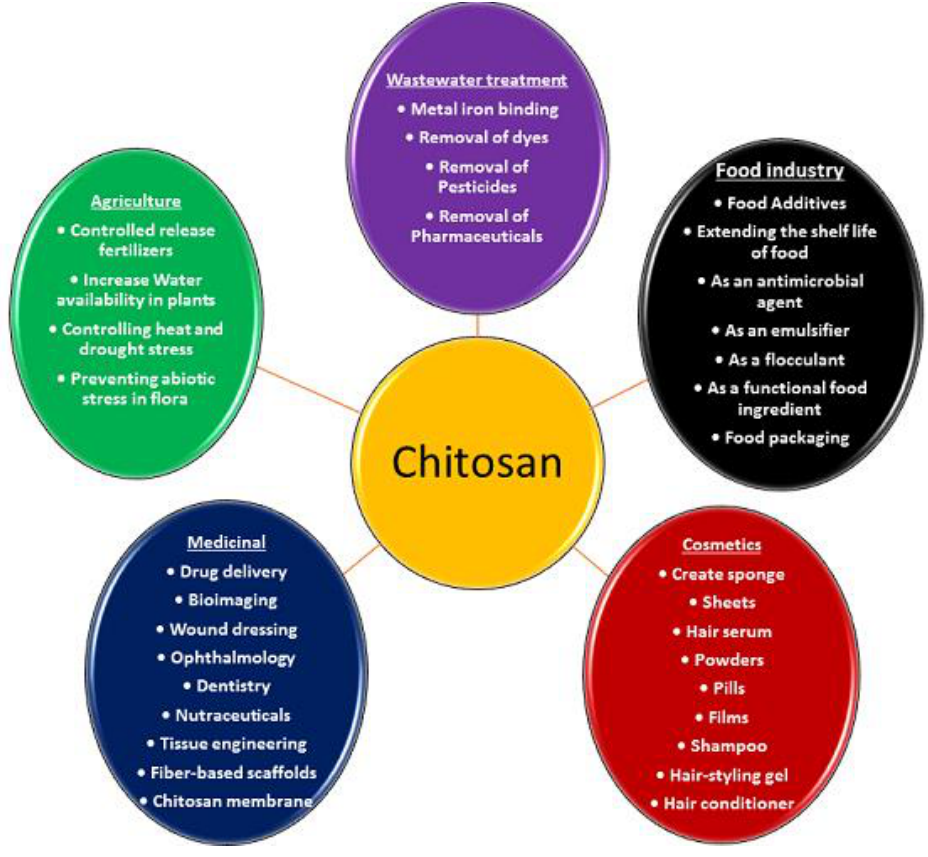
Figure 3. Applications of chitosan-based materials.